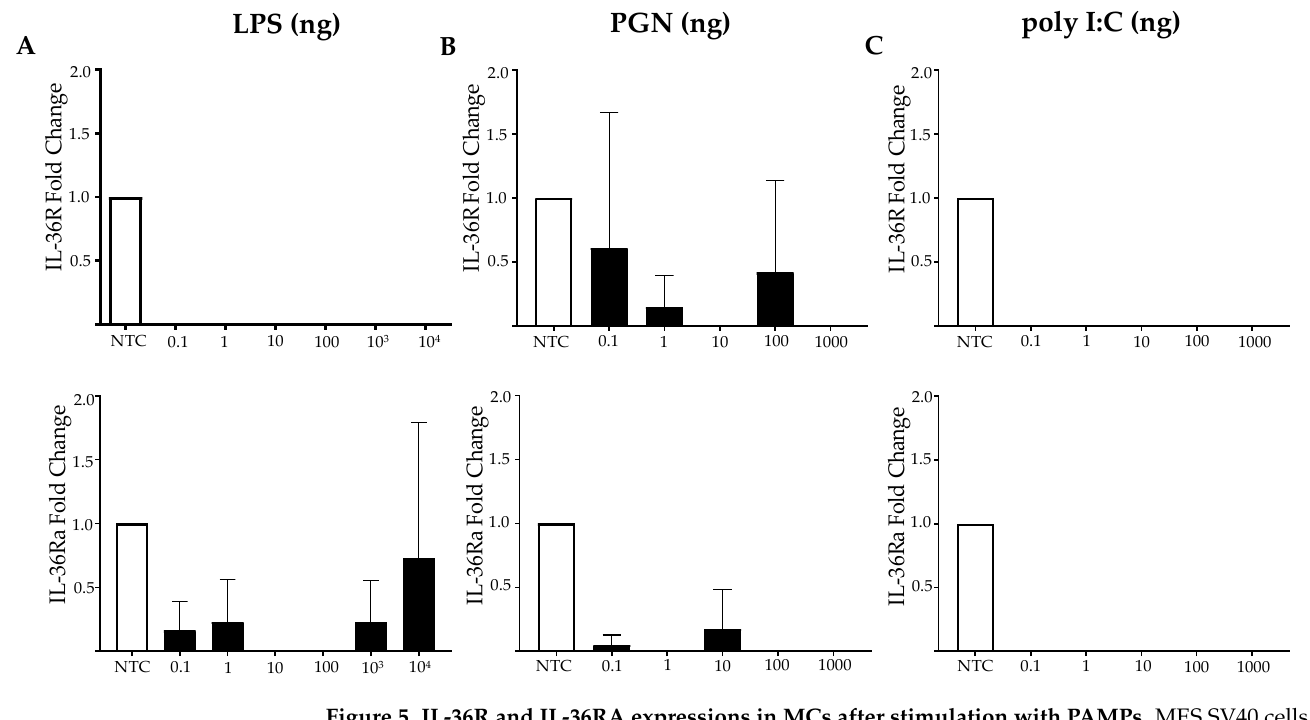
Figure 5 . IL-36R and IL-36RA expressions in MCs after stimulation with PAMPs. MES SV40 cells (1.5 × 10 6 ) were stimulated in 2 mL of medium containing different amounts of ( A ) LPS; ( B ) PGN; ( C ) poly I:C, and the mRNA expressions of IL-36R and IL-36Ra were measured. The expression was normalized against Actb, and the fold change was calculated in comparison to the respective non-stimulated control. The results were obtained from at least 3 independent experiments and are listed as mean ± SD.